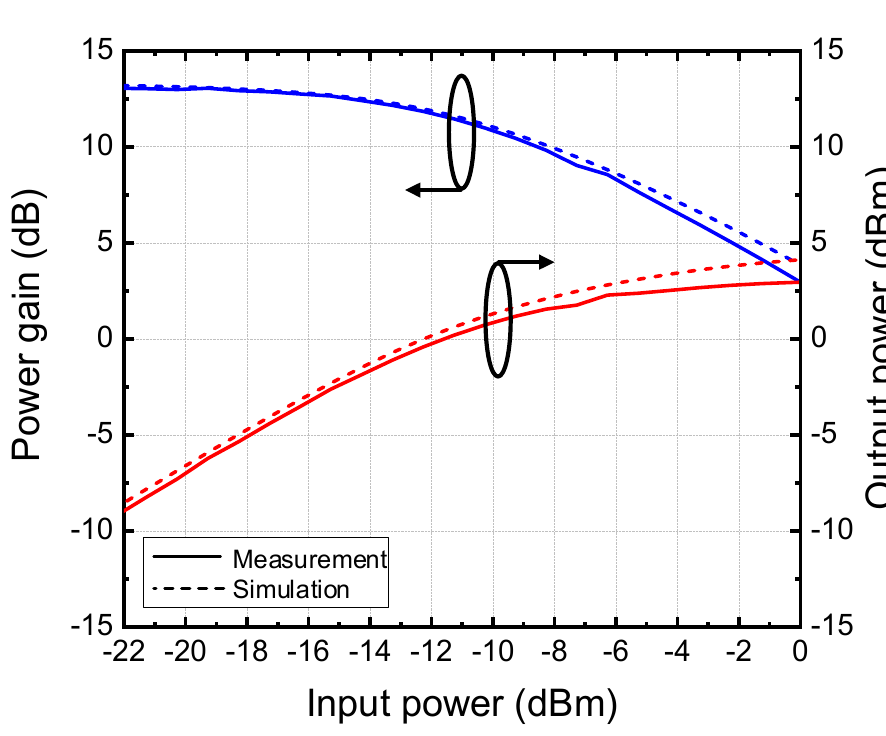
Figure 12. Measured output power and gain versus input power at 34 GHz.